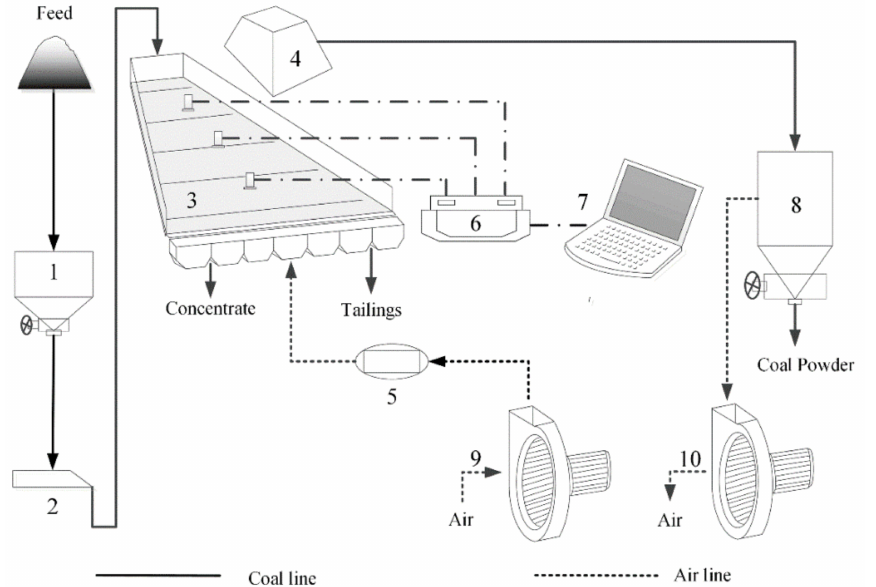
Figure 3. Apparatus for vibratory combined force field fluidized bed: 1—surge bunker,